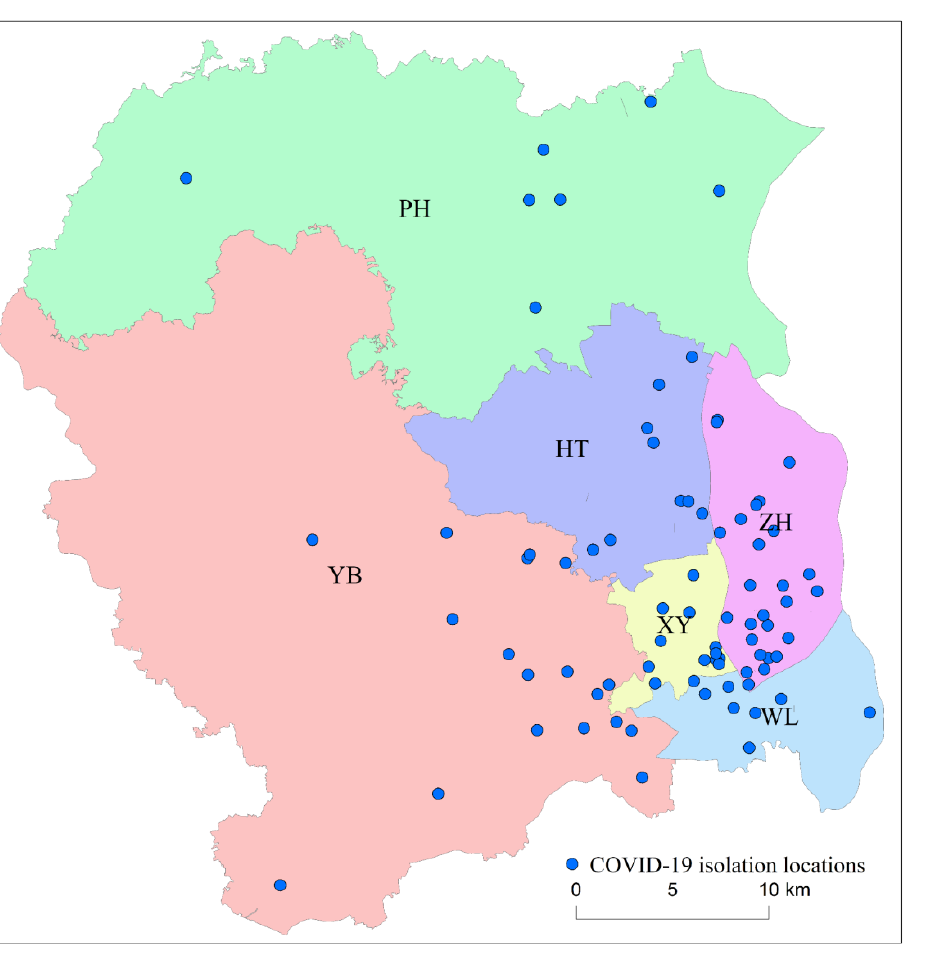
Figure 1. COVID-19 isolation locations, with colored areas representing districts in ZG City,